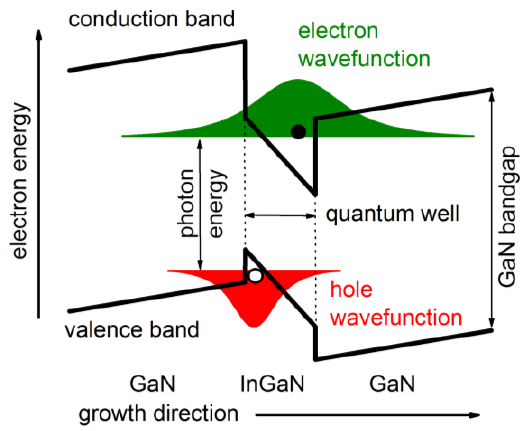
Figure 7. Illustration of polarization effects on an InGaN/GaN quantum well in the common Ga-polar growth direction (N-polar growth reverses the polarization field [69]).